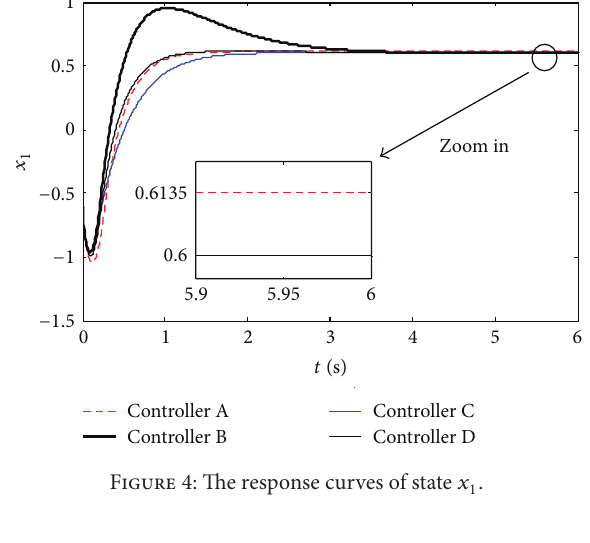
Figure 4: The response curves of state 𝑥 1